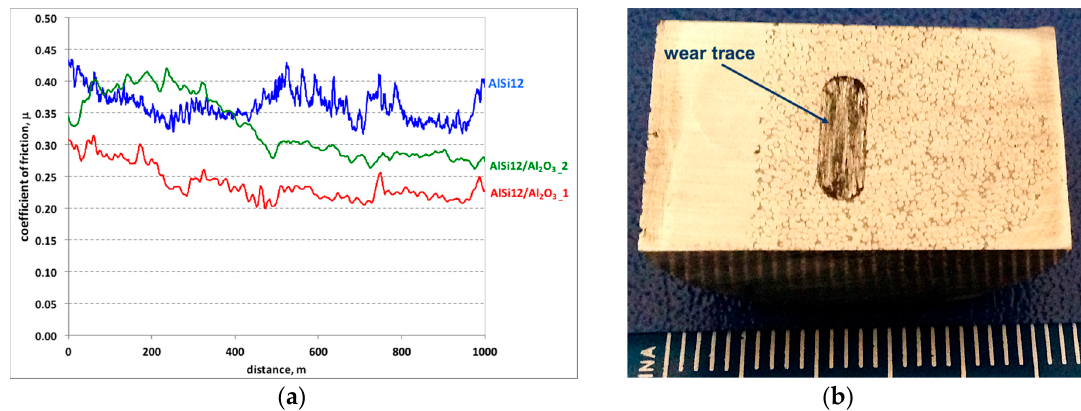
Figure 4. Friction coefficient ( μ ) versus sliding distance for un-reinforced area (AlSi12 matrix alloy) and AlSi12/Al 2 O 3 foam composite layers ( a ); view of AlSi12/Al 2 O 3 _1 composite surface after dry sliding wear test ( b ).